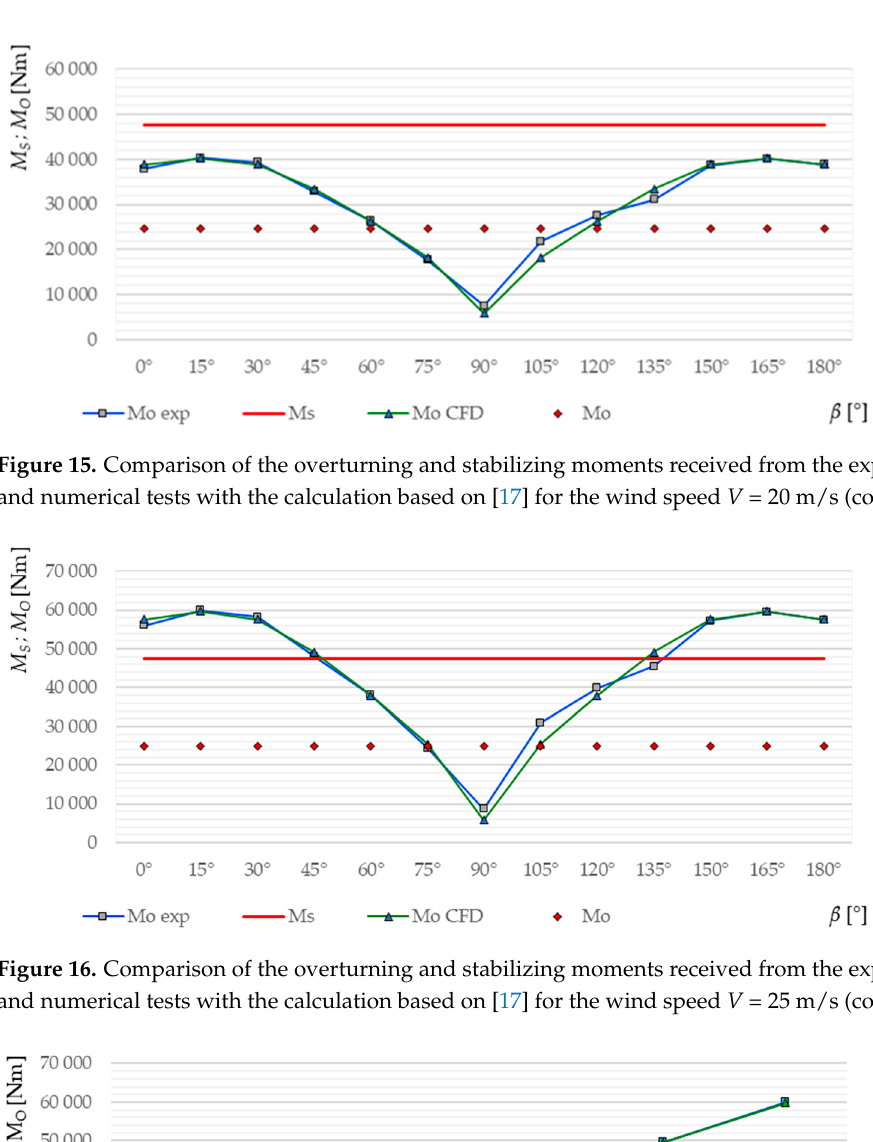
Figure 16. Comparison of the overturning and stabilizing moments received from the experimental and numerical tests with the calculation based on [17] for the wind speed V = 25 m/s (config. 1). Taking the above discussed results into account, the characteristics of the overturning moment as a function of wind speed for the angle of 15° can be determined (Figure 17).